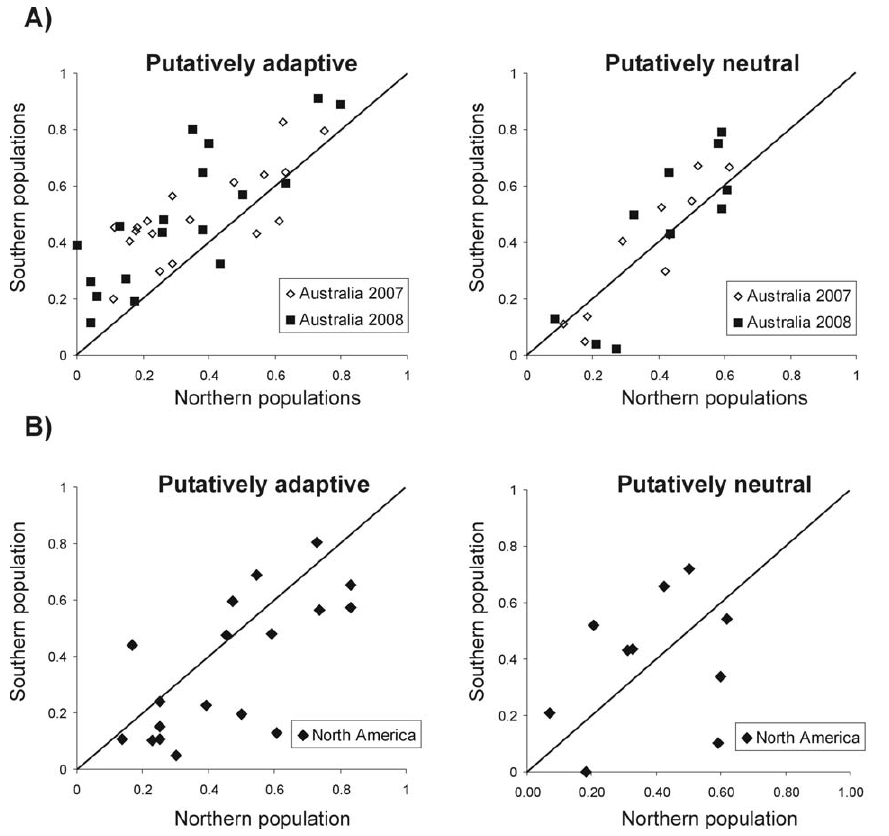
Figure 2. Frequencies of the putatively adaptive and putatively neutral TEs. In the northern versus the southern populations in Australia (A) and North America (B).